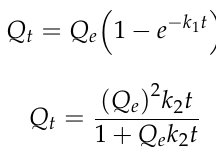
Table 3. Kinetic parameters of phosphorus adsorption onto